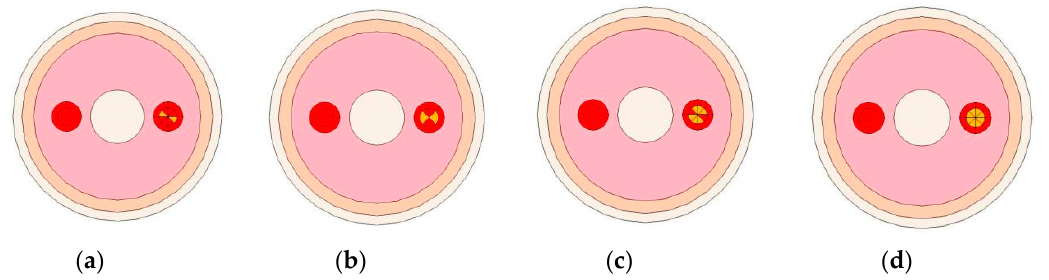
Figure 10. The simulation models of arterial with different rates of stenosis: ( a ) Rate of stenosis: 25%; ( b ) rate of stenosis: 50%; ( c ) rate of stenosis: 75%; and ( d ) rate of stenosis: 100%. The same blood flow was injected into each artery, and the induced potential di ff erence was obtained by COMSOL. The simulation results are shown in Figure 11.